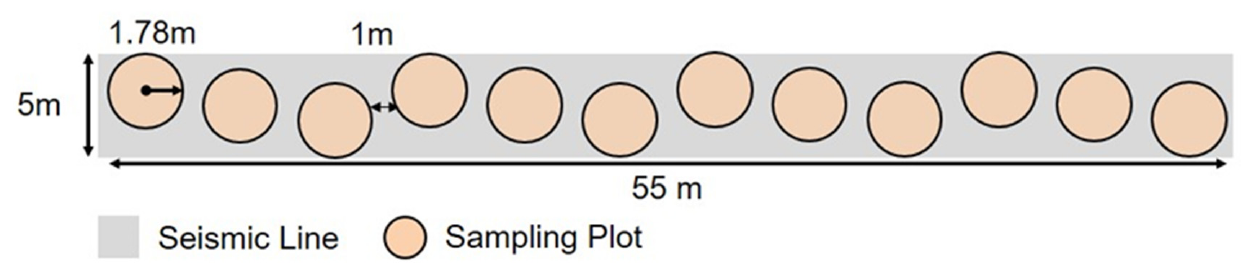
Figure 4. Layout of circular plots within a transect on a seismic line.